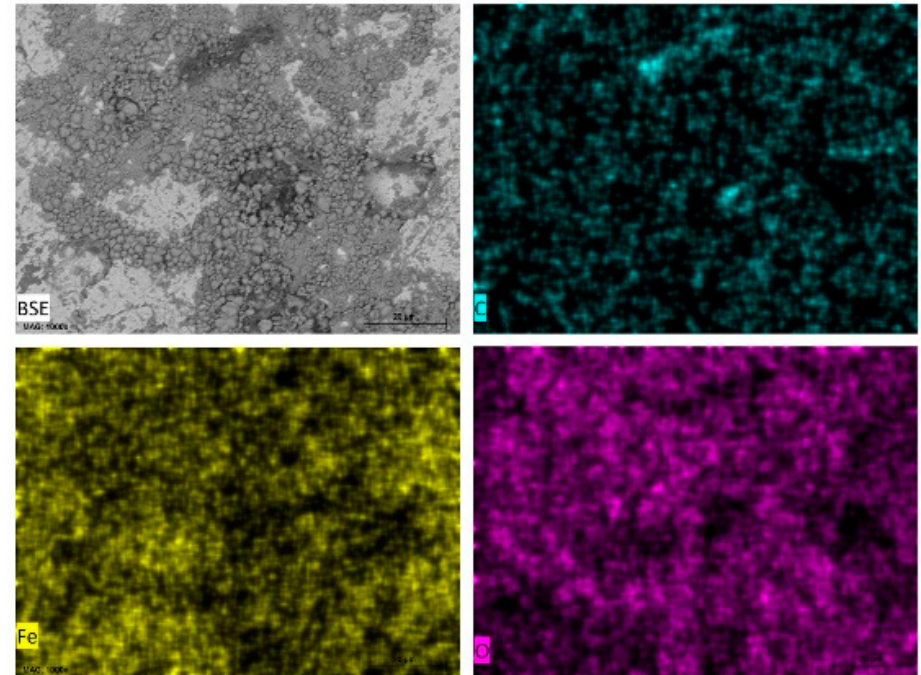
Figure 6. SEM/EDS mapping images of carbon steel sheet (CR1 ≈ EN 1.0338) surfaces after immer- sion in tomato juice (pH = 4.24).